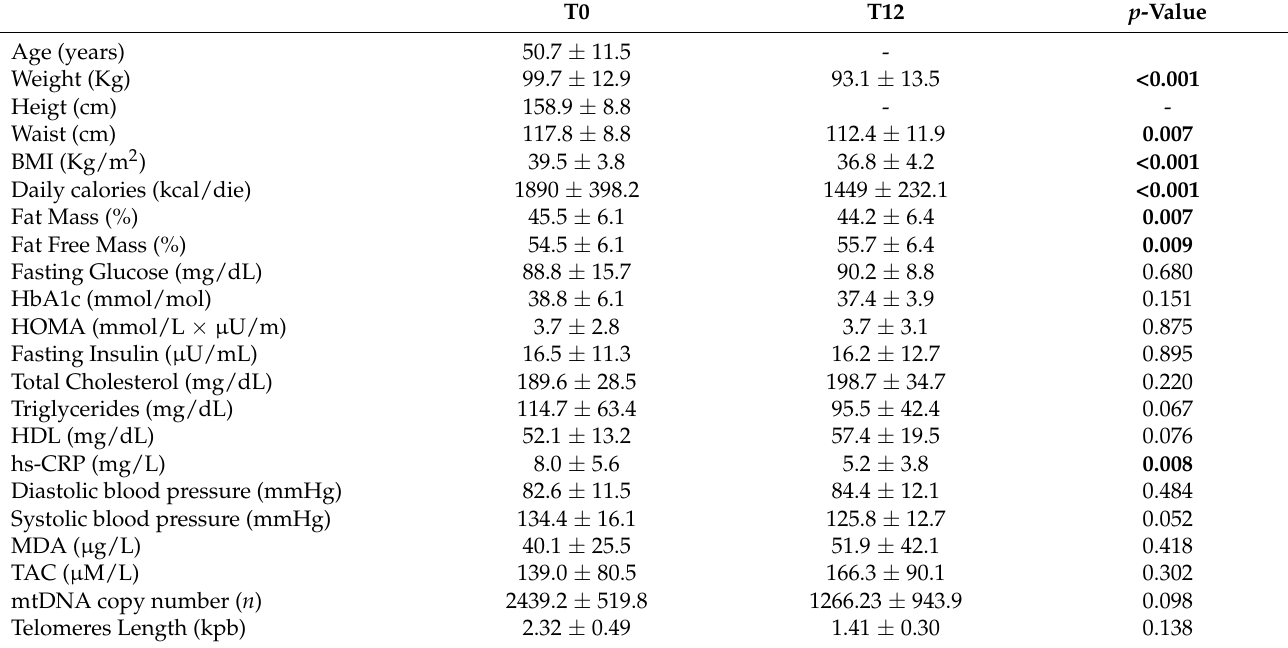
Table 1. Characteristics of the study participants ( n =